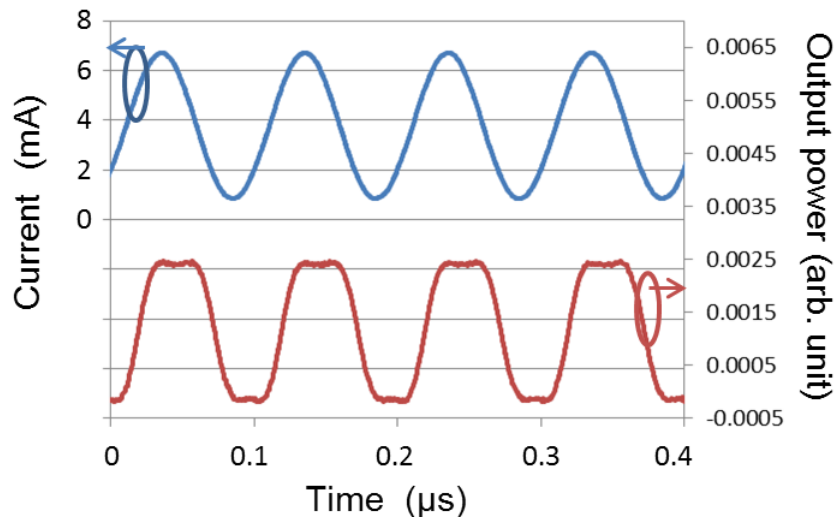
Figure 9. Output power of an MZI modulator with MMI phase modulator driven by alternating current (AC) power.